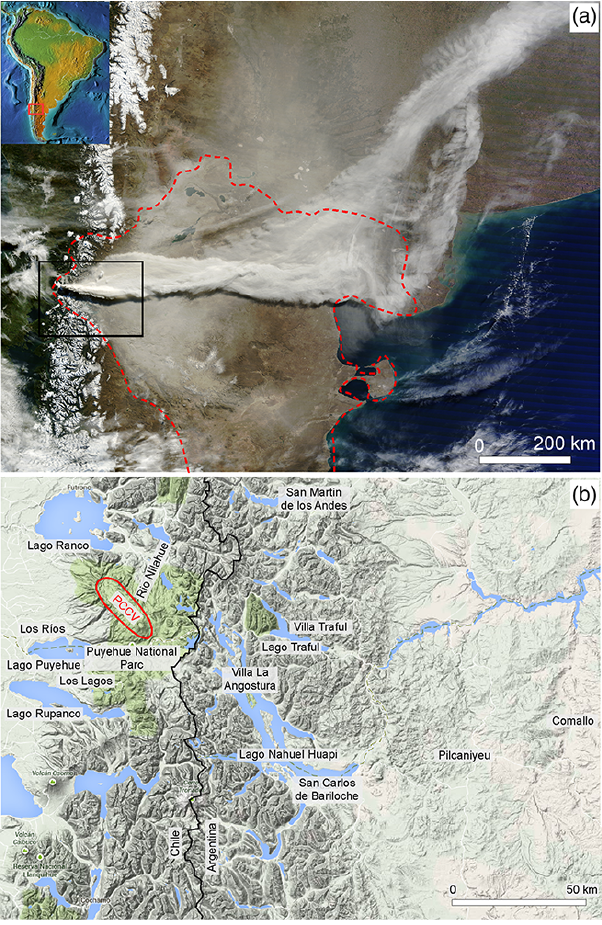
Figure 1. (a) Nasa image from Moderate Resolution Imaging Spec- troradiometer (MODIS) on the Terra satellite, showing ash on the ground and a large plume streaming east from Puyehue volcano on 13 June 2011. The red dashed line indicates the extension of the tephra deposit (Gaitán et al., 2011). The black square represents the area shown in (b) . (b) Google image of the proximal area affected by tephra fallout, between Chile and Argentina (border is the black